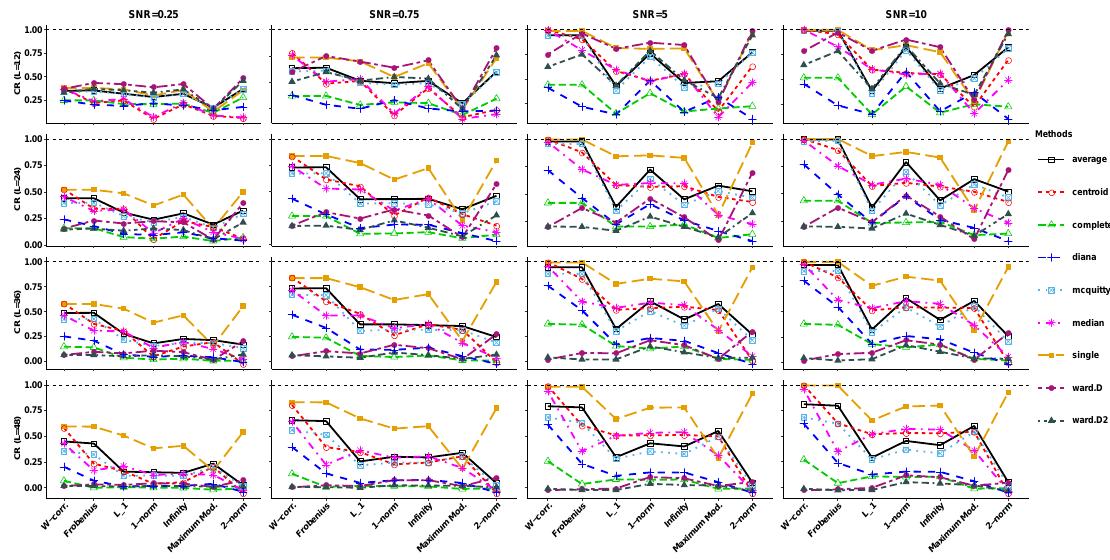
Figure 5. CR index for the cosine + cosine series (case